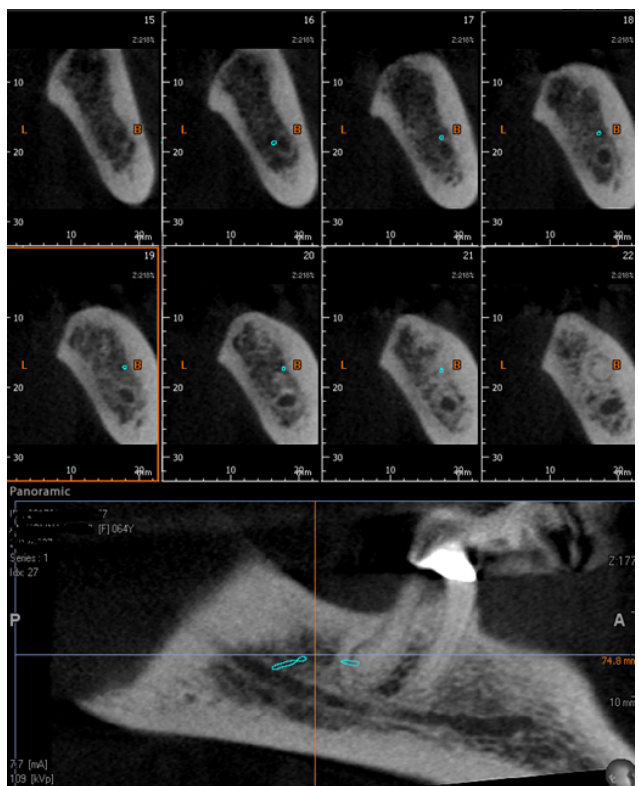
Figure 6. Type 2, dental canal: cross and Panorex reconstructions. Reconstruction shows arrival at the apex of the 4.7 tooth element.